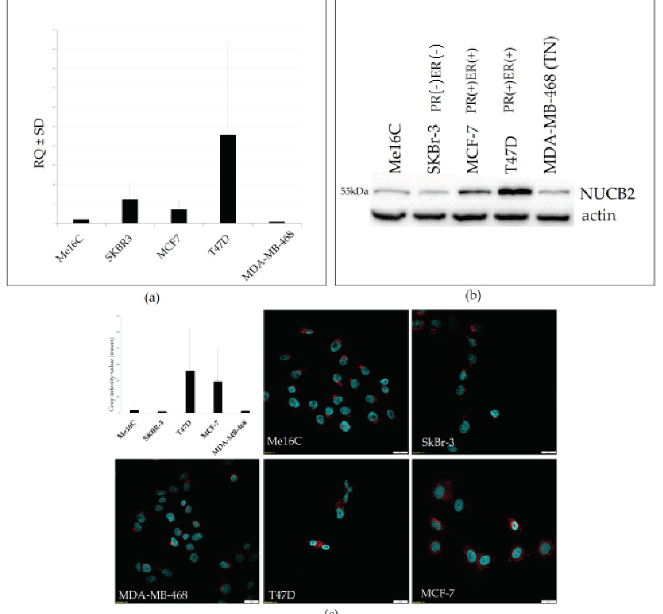
Figure 7. Comparison of NUCB2 expression levels detected by real-time PCR (mRNA) ( a ), Western blot ( b ) and confocal microscopy ( c ) in normal human breast epithelial cell line hTERT-HME1 and different cancer cell lines (MCF7, T47D, SK-BR-3, MDA-MB-468).